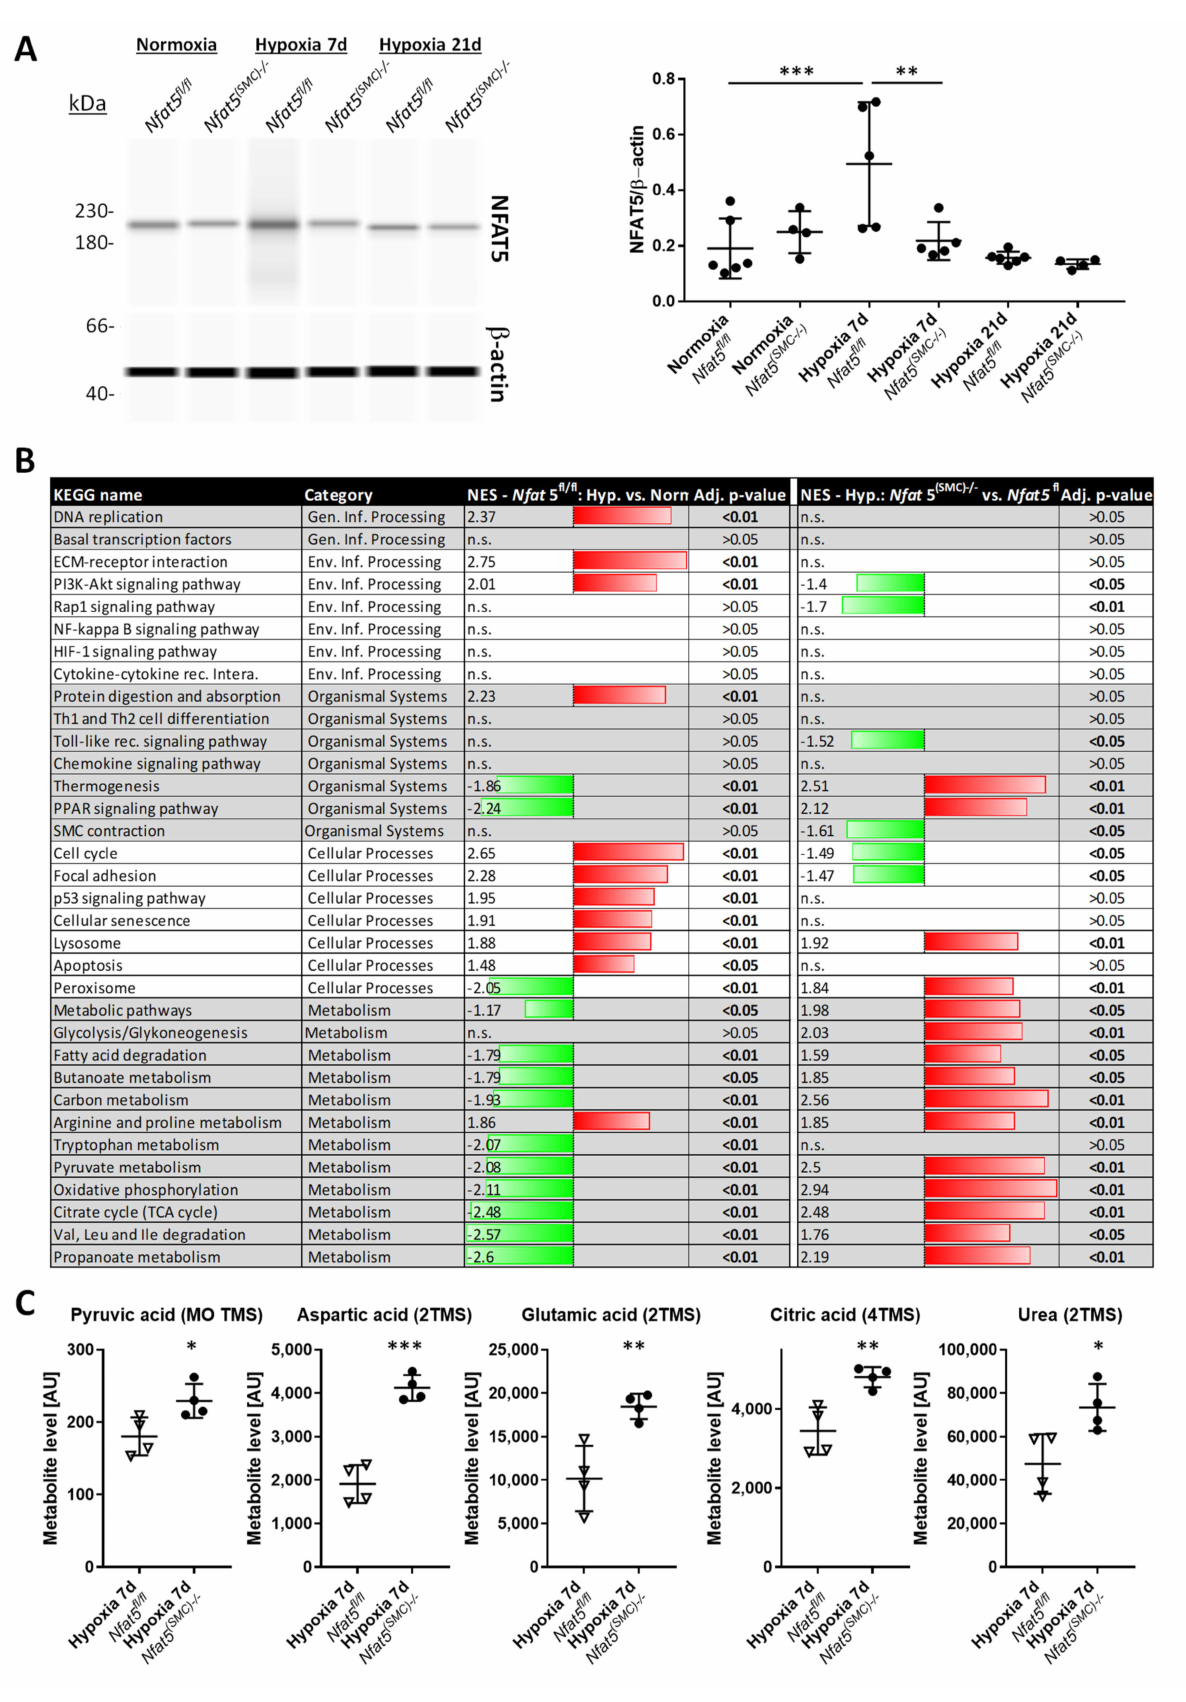
Figure 3. Gene set enrichment and metabolome analysis of Nfat5 fl/fl and Nfat5 (SMC) − / − lungs exposed to